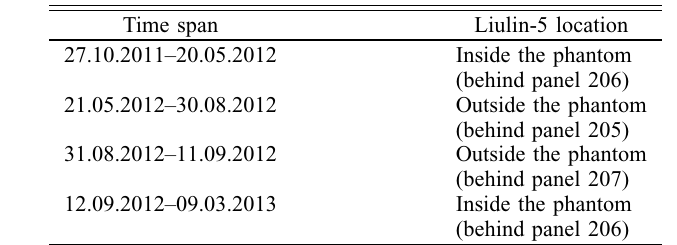
Table 1. Location of the Liulin-5 detector in MIM1 module during the second stage of the experiment on the